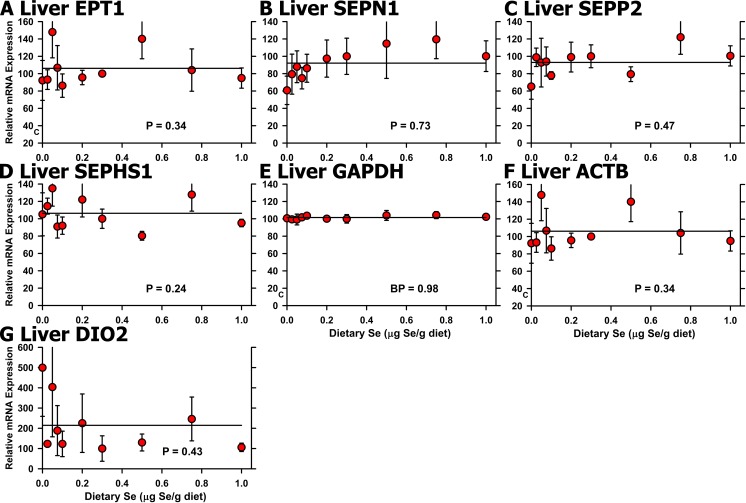
Effect of dietary Se on unregulated selenoprotein transcript levels in chick liver.Relative transcript levels are plotted for EPT1 (A), SEPN1 (B), SEPP2 (C), SEPHS1 (D), GAPDH (E), ACTB (F), and DIO2 (G) in chicks supplemented with the indicated levels of dietary Se for 29 d. Values were determined in triplicate for each sample, normalized to the mean of GAPDH and ACTB levels in each sample, expressed as a percentage of Se-adequate plateau levels, and plotted as mean±SEM (n = 3-4/treatment). Overall level of significance, as determined by ANOVA, is indicated in each panel.